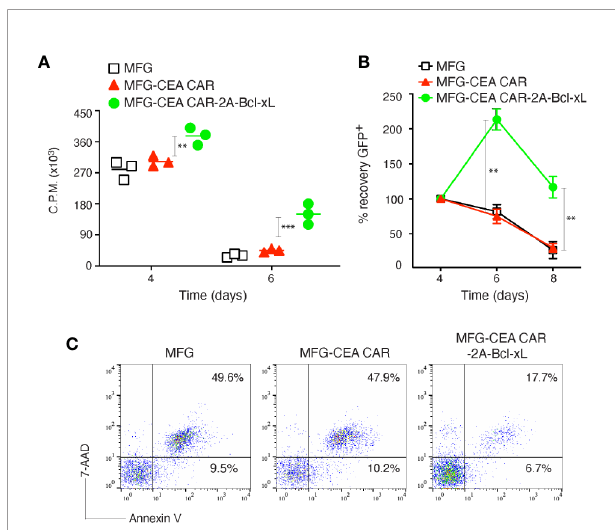
FIGURE 2 | Carcinoembryonic antigen (CEA) chimeric antigen receptor T (CAR-T) cells overexpressing Bcl-xL had enhanced proliferation and survival in vitro . Naive CD8 + T cells from C57BL/6 mice were stimulated with anti-CD3 plus anti-CD28 antibodies, and transduced on days 2/3 with retroviral vectors expressing GFP, GFP with CEA CAR, or GFP with CEA CAR and Bcl-xL, and then re-cultured without any further stimulation. (A) Primary passive proliferation on day 4 and day 6 were measured in unseparated cultures by pulsing with tritiated thymidine for 20 h. Data are represented with a mean of three independent experiments (** P < 0.01, *** P < 0.001, Student ’ s unpaired t -test). (B) GFP + CD8 + T cell recovery normalized to take into account differences in initial transduction ef fi ciency between cultures. Numbers of GFP + cells present on day 4 were assigned a value of 100%, and numbers surviving on day 6 and day 8 were used to calculate the percentage recovery relative to day 4. The data represent the mean ± S.E.M. percentage change from three separate experiments (* P < 0.05, ** P < 0.01, Student ’ s unpaired t - test). (C) Apoptosis of GFP + CD8 + T cells on day 6 based on staining